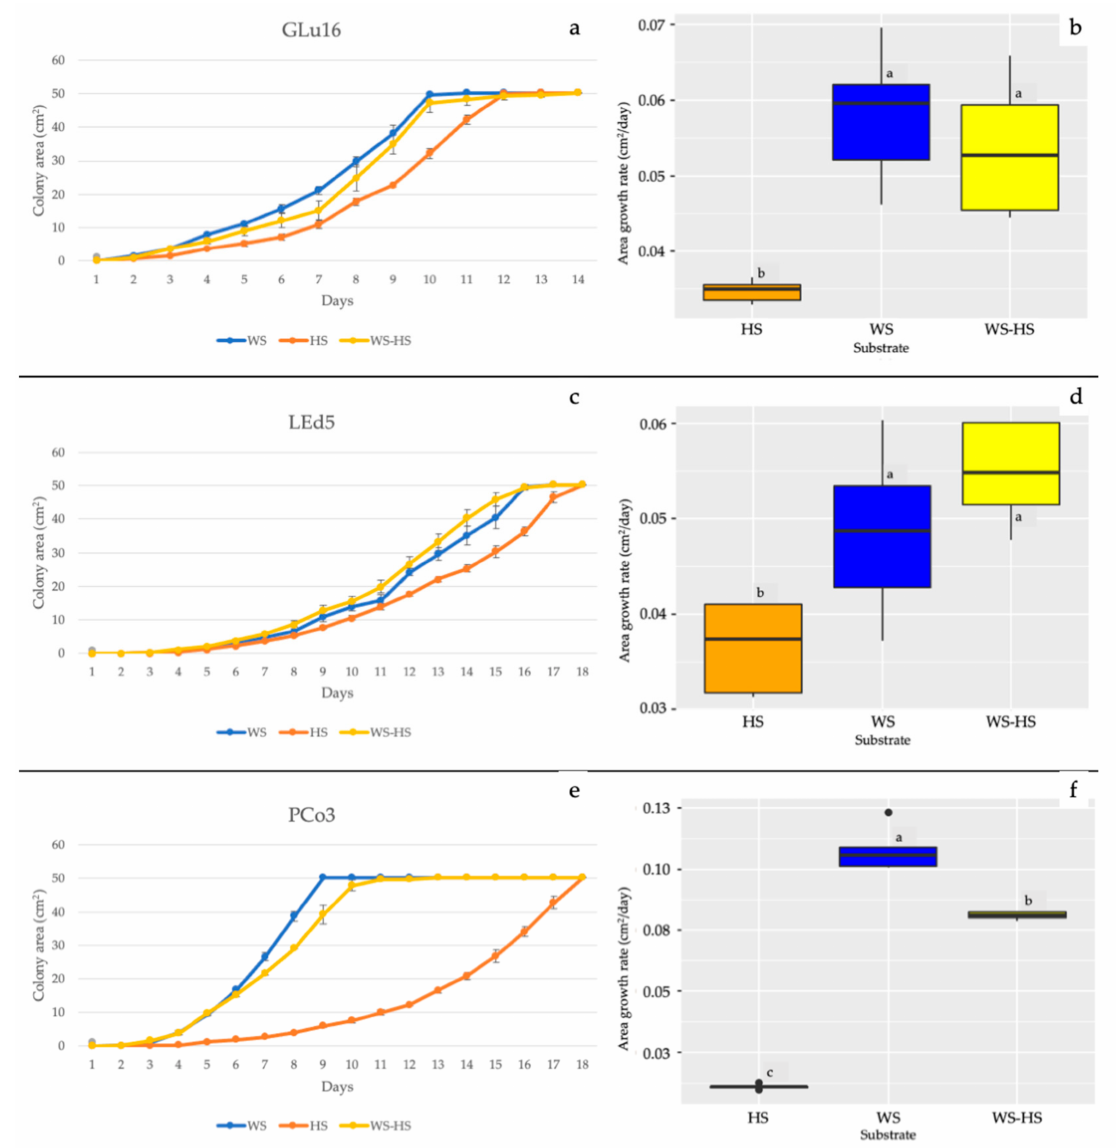
Figure 1. Growth and AGR of ( a , b ) Ganoderma lucidum , ( c , d ) Lentinula edodes, and ( e , f ) Pleurotus cornucopiae in Petri dishes on WS (blue), HS (orange), and WS-HS (yellow). Different letters indicate significant differences at p ≤